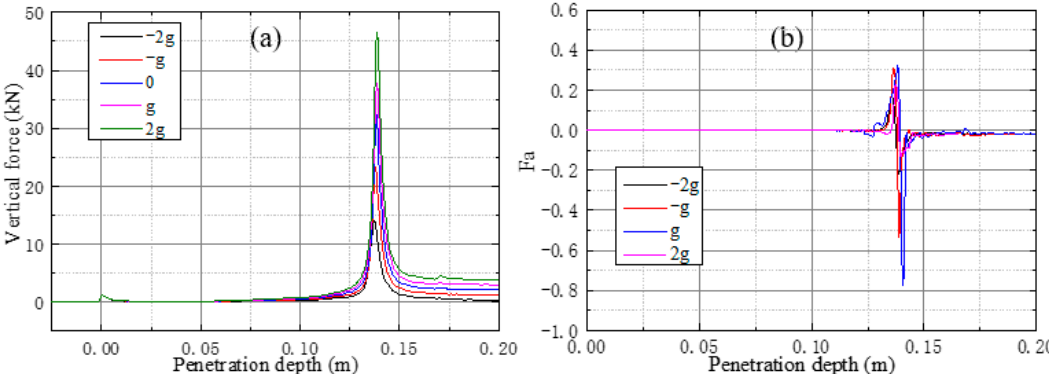
Figure 10. The vertical force varying the penetration depth for different constant entry acceleration and F a estimated from these CFD results (( a ) Vertical forces against penetration depth under five acceleration; ( b ) The separated drag coefficient F a .)